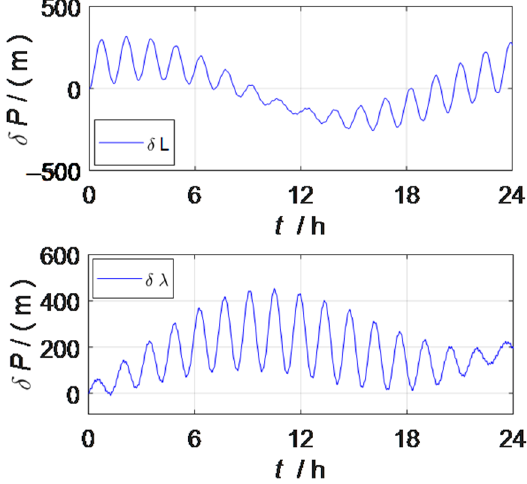
Figure 4. Position error of the rotation strapdown inertial navigation system.